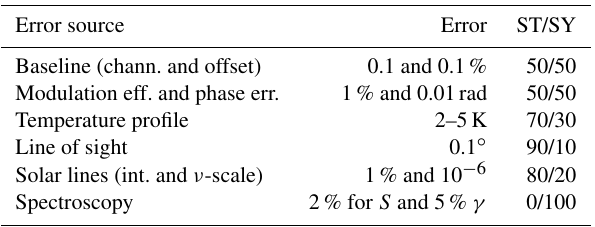
Table A1. Error sources used for the theoretical error estimation for all the FTS products (chann.: channeling; eff.: efficiency; err.: error; int.: intensity; ν -scale: spectral position; S : intensity; γ : pressure broadening parameter). The second column gives the assumed error value and the third column the partitioning of this error between statistical (ST) and systematic (SY) contributions (Sepúlveda et al., 2014).